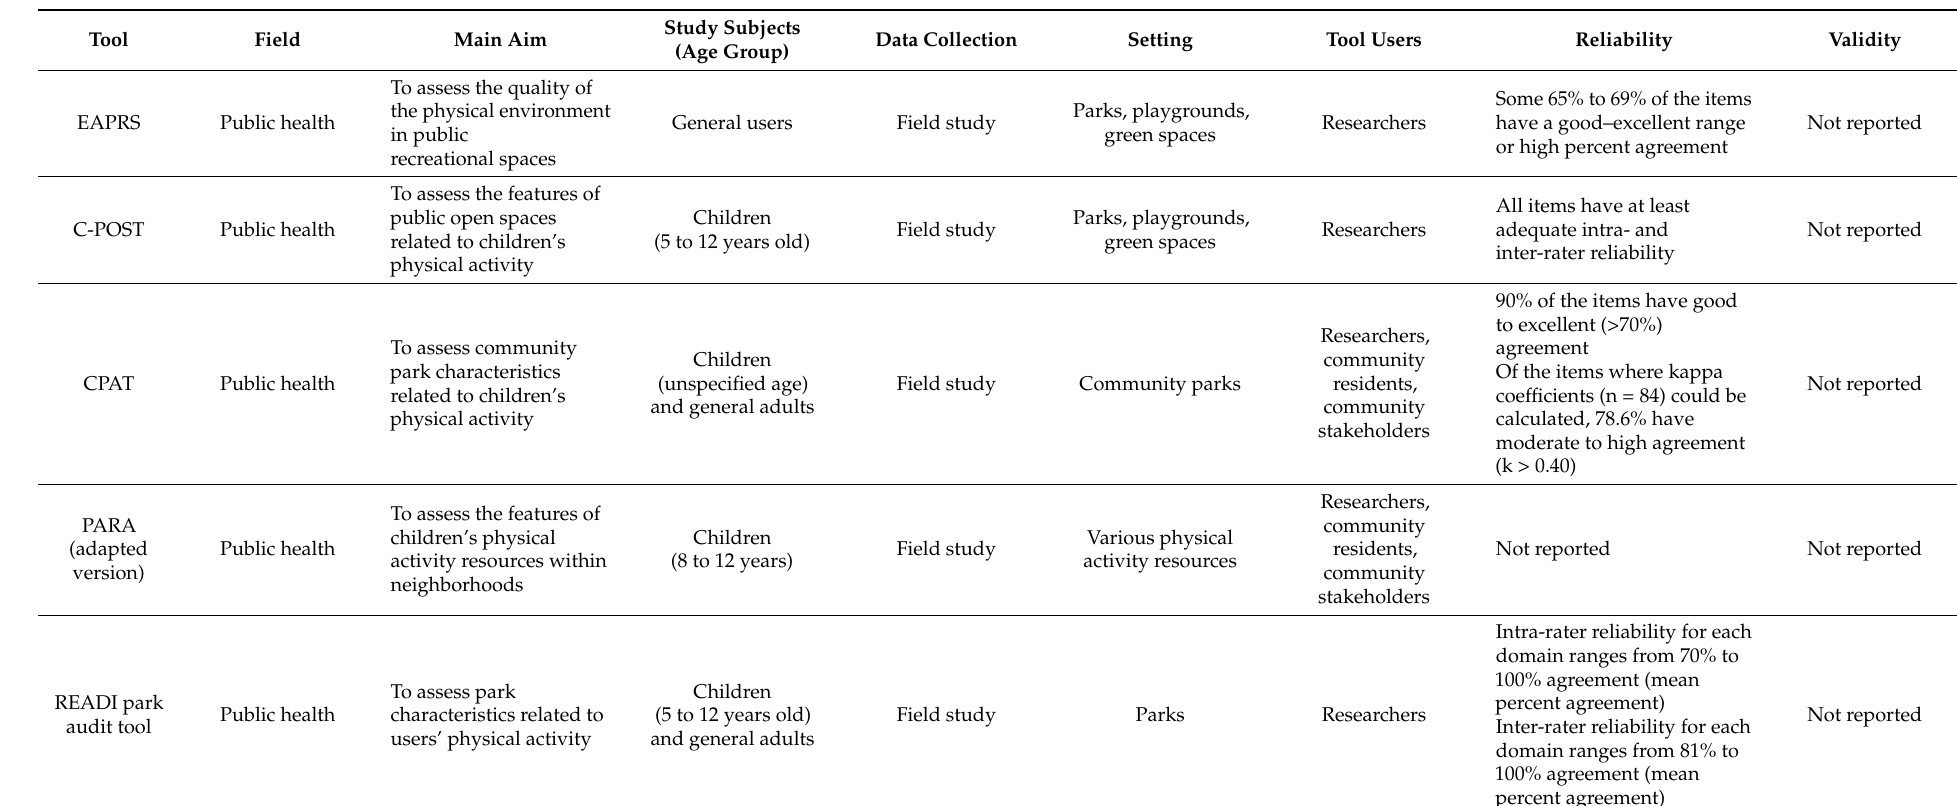
Table 2. Audit Tool